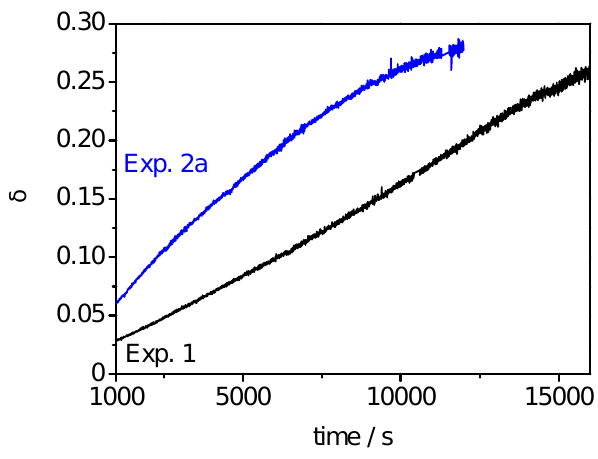
Fig. 6. Time series of the backscattering linear depolarisation ratio, δ from Exp. 1 (black line) and Exp. 2a (blue line), recorded during the second crystallisation periods after the end of the first expansion cooling cycles (Fig. 5) while cooling the AIDA chamber to 235K. The records end with the start of the second expansion cooling cy- cles which are shown in Fig.